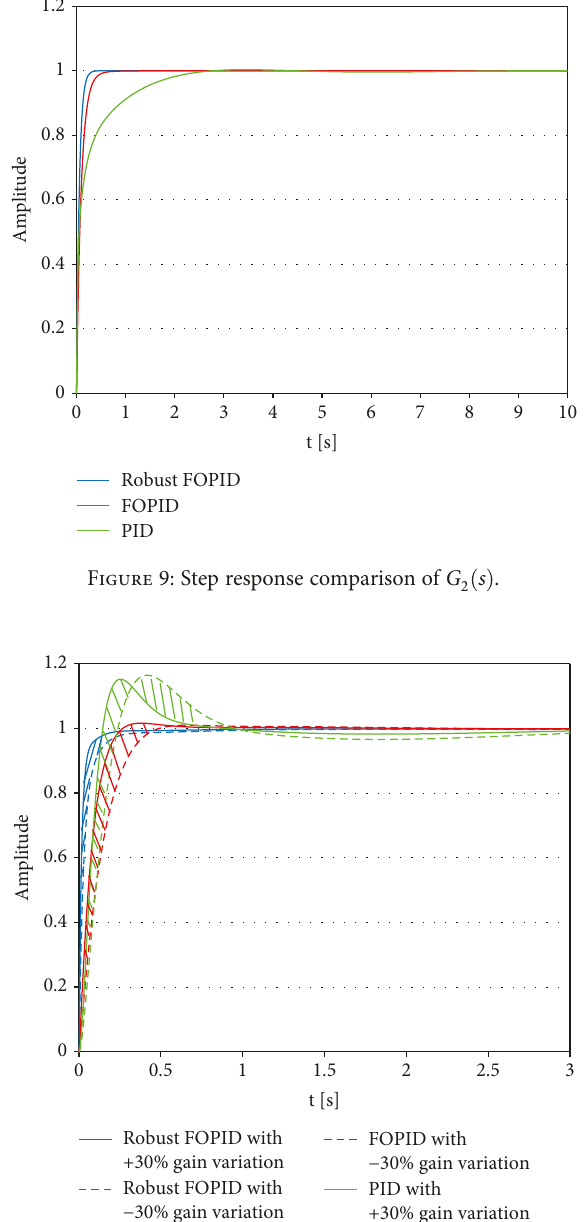
Figure 10: Step response comparison of G uncertainties.